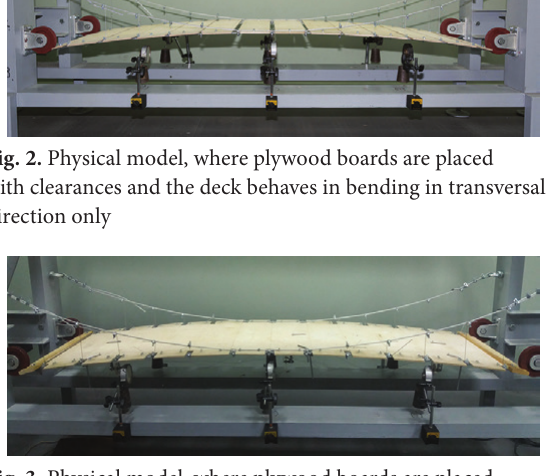
Fig. 3. Physical model, where plywood boards are placed without the clearances and the deck behaves in both directions Table 1. Characteristics of cable elements of the physical models Elements Cable type